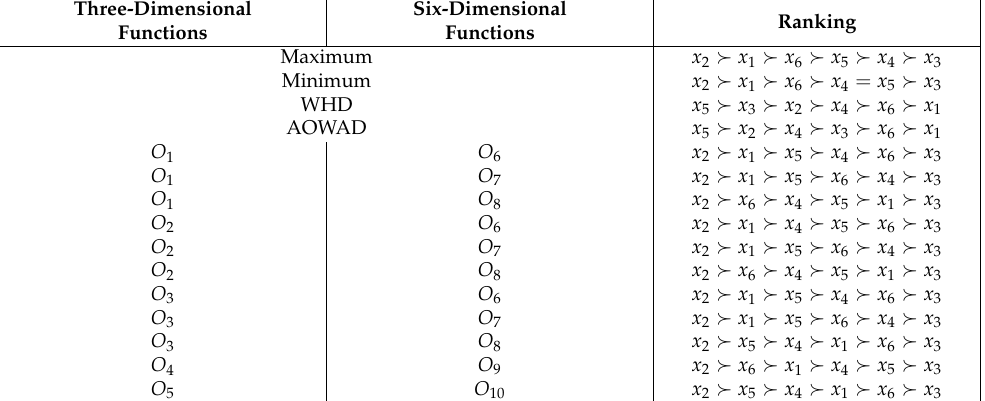
Table 11. Summary of the permutations gained with presented means as well as other methods. Three-Dimensional